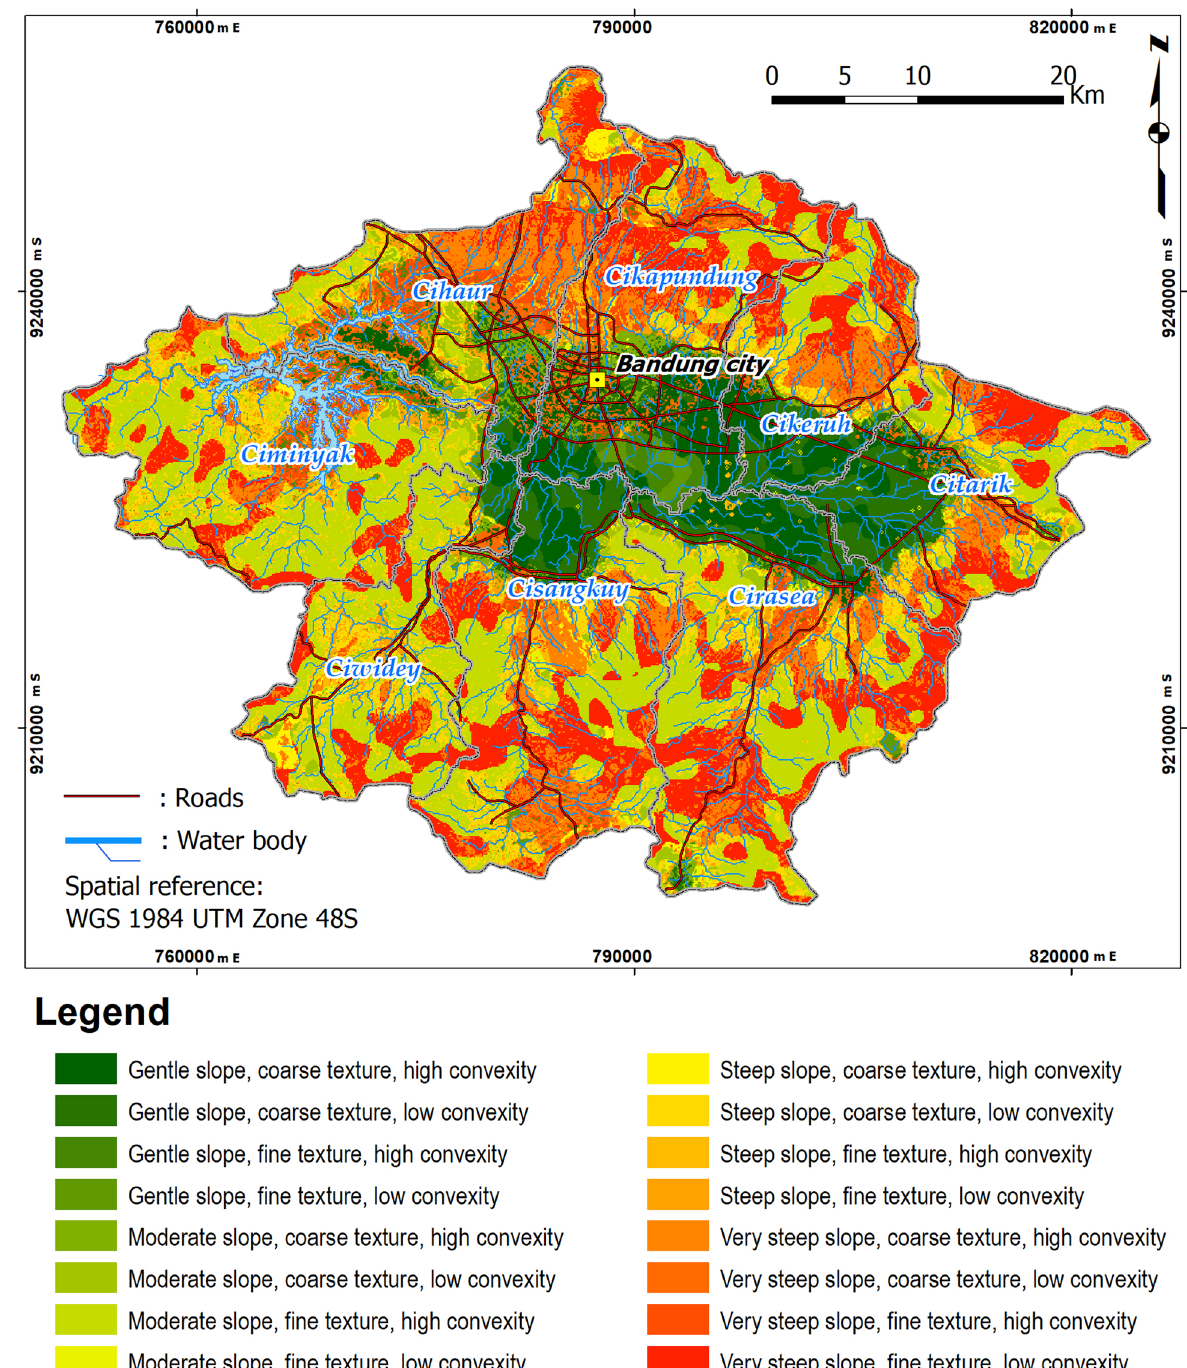
Fig. 7. Results of the terrain surface classification (TSC) as a micro-landform classification in the study